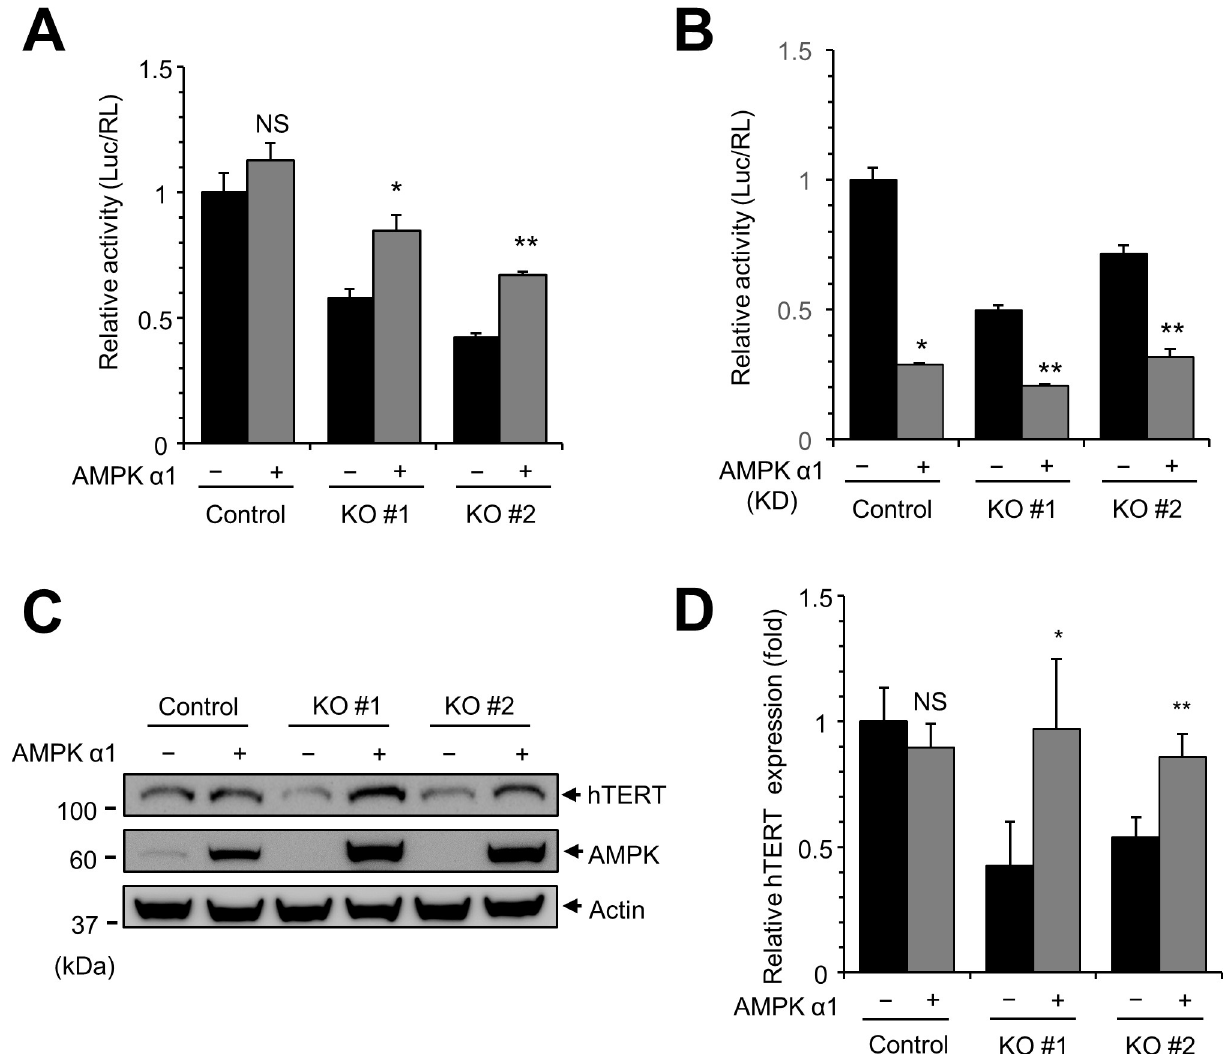
Fig 6. Transient expression of AMPK α 1 rescues hTERT expression. ( A ) Transient expression of AMPK α 1 rescues hTERT-Luc activity. Control cells and AMPK α 1 KO cells were transfected with hTERT-Luc plasmid with either empty vector or plasmid encoding AMPK. At 24 h after transfection, luciferase reporter activity was measured. Luciferase activity was normalized to activity of Renilla luciferase. Empty vector vs. AMPK α 1, � P < 0.05, �� P < 0.01, NS, not significant. ( B ) Transient expression of AMPK α 1 kinase dead (KD) does not rescue hTERT-Luc activity. ( C ) Transient expression of AMPK α 1 increases the level of hTERT protein in AMPK α 1 KO cells. AMPK α 1 KO cells were transfected with either empty vector or plasmid encoding AMPK α 1. At 24 h after transfection, cell lysates were subjected to western blotting with anti-hTERT antibodies and anti-AMPK antibodies. ( D ) Quantification of hTERT and AMPK bands.